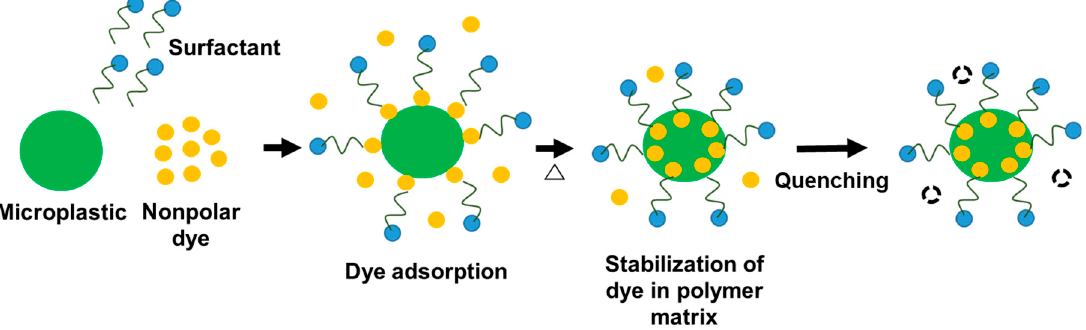
Scheme 1. Schematic representation of the staining procedure of MPs in water with nonpolar dye and surfactant.